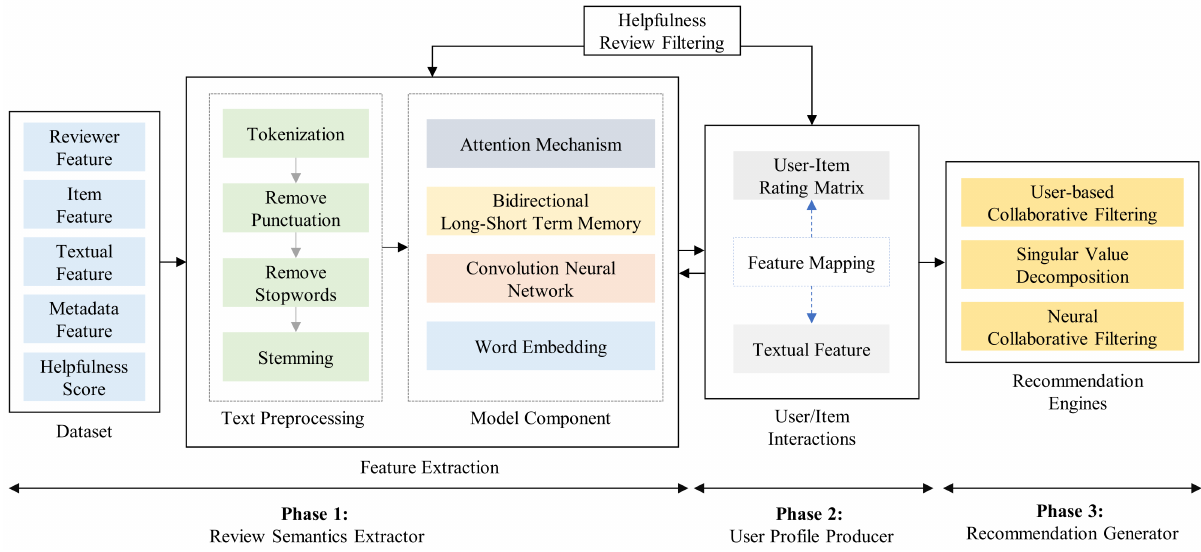
Figure 1. Proposed RHRM